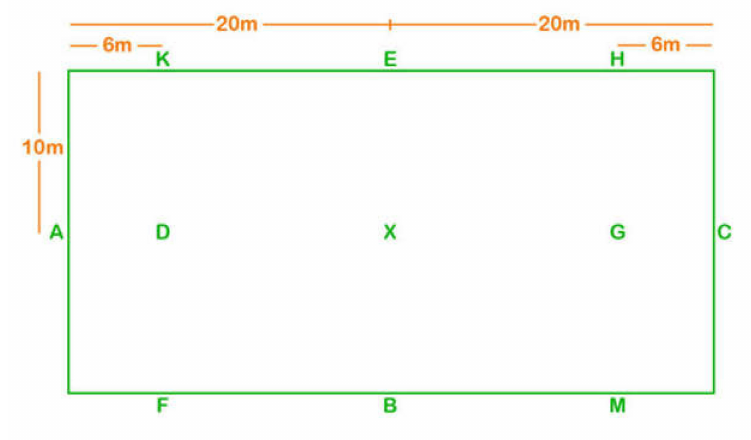
Figure 1. Layout of the dressage arena in which 60 horse rider combinations performed a custom-written dressage test (Table S1). The video recorder stood between M and C, and H and C, for movements 1–9 and 11–26,